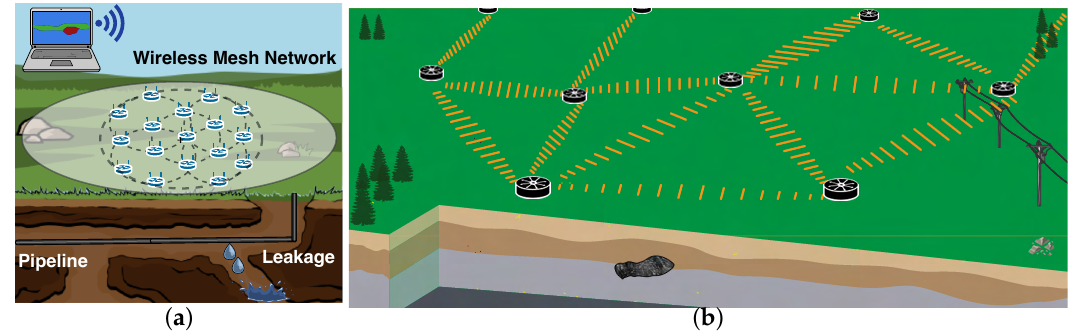
Figure 1. Concept of ambient noise seismic imaging on distributed sensor networks: ( a ) small array (m); and ( b ) large array